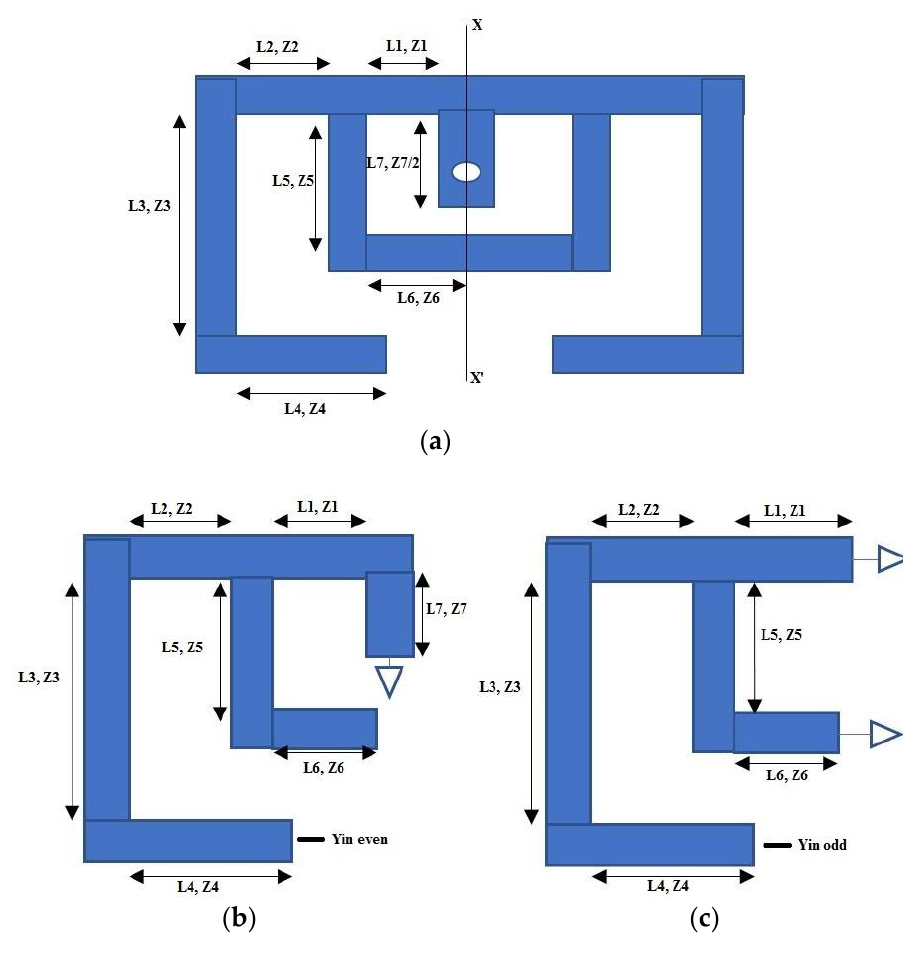
Figure 9. ( a ) The presented geometry of the quad-mode stub-loaded resonator. ( b ) Even-mode excitation circuit. ( c ) Odd-mode excitation circuit.